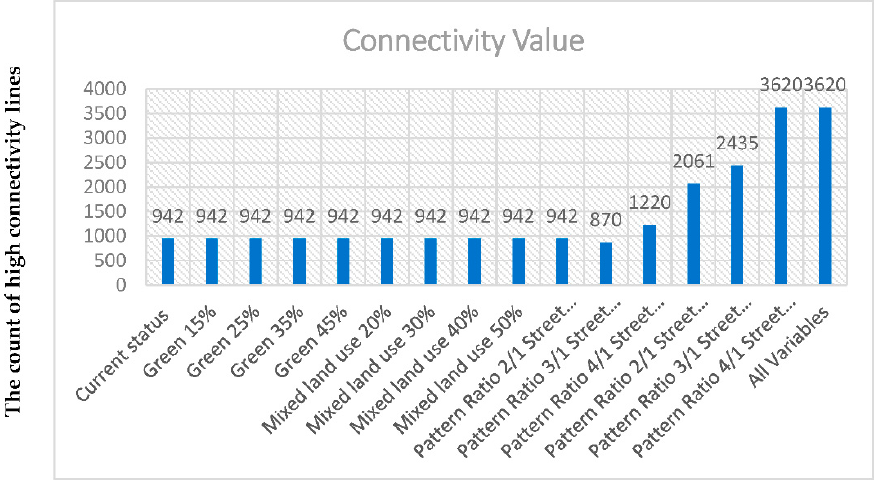
Figure 6. The connectivity results for the various scenarios. Source: Designed by the researchers according to the previous simulation results.